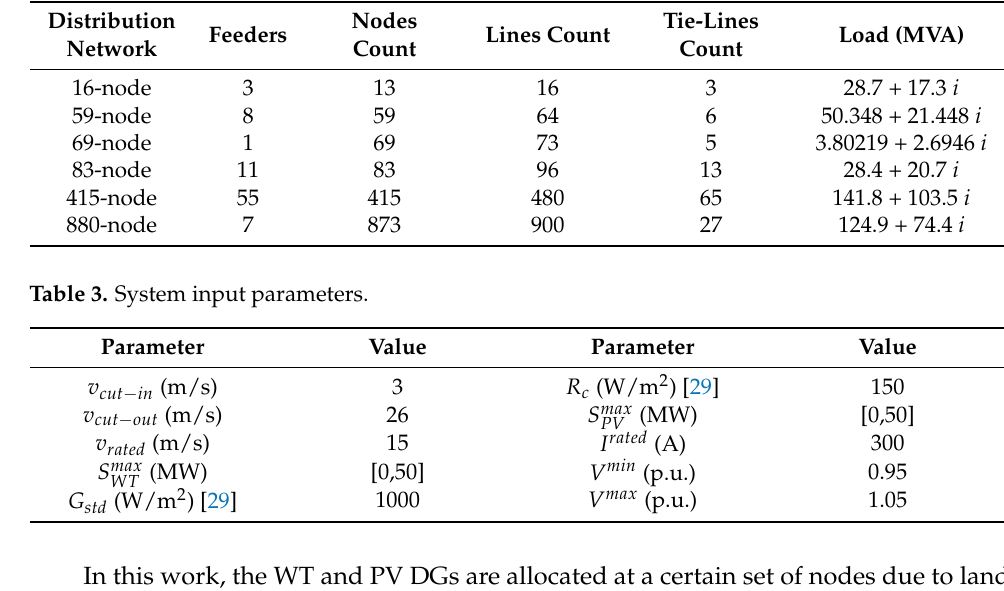
Table 2. Distribution test networks data.